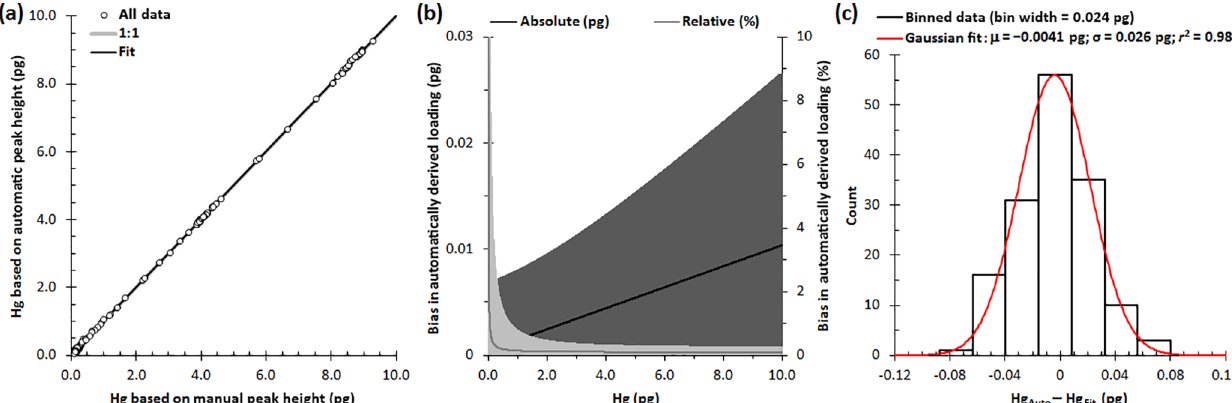
Figure 5. (a) Comparison of Hg loadings derived from measurements made with a Tekran ® 2537A instrument using my VI-based automated and manual peak height determination methods (the VI a,a and VI m,m methods, respectively; dataset shown in Fig. 2, excluding SPANs). The equation of the linear regression is y = 1 . 001 ( 1 )x + 0 . 000 ( 6 ) pg ( r 2 = 0 . 99992, n = 152). (b) Absolute and relative biases in the VI-based Hg loadings, based on the fit in panel (a) ; grey bands represent propagated uncertainties (95% confidence intervals) in the parameters of the fit in panel (a) . (c) Distribution of residuals from panel (a)